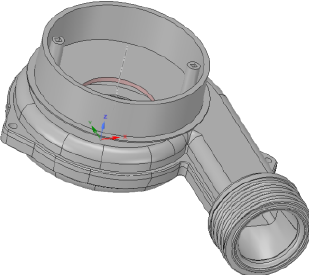
Fig. 2 Design of fan diffuser under investigation.